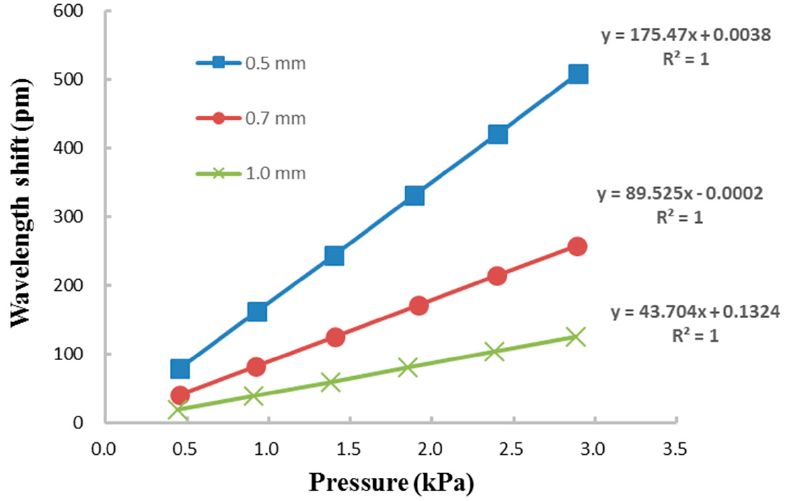
Table 4. Comparisons of the pressure and water level sensitivities between the present and other FBG sensors reported in the literatures.